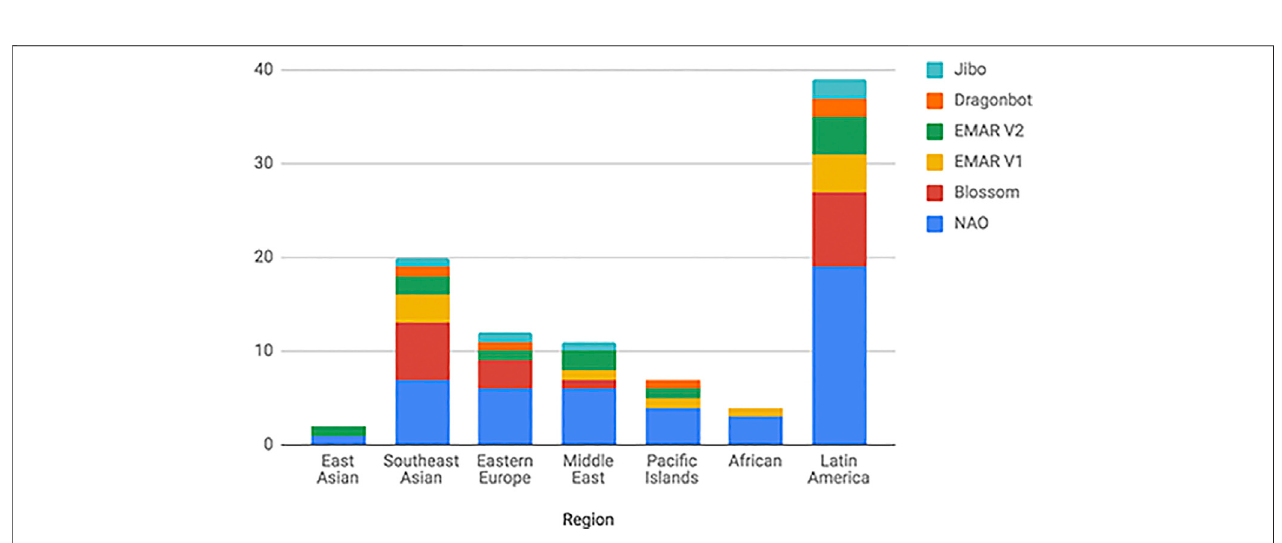
FIGURE 7 | Illustration of student robot preferences by home language